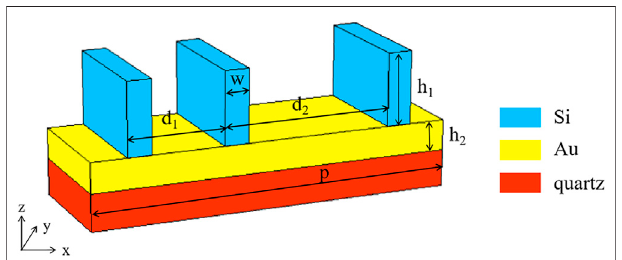
FIGURE 1 | Three-dimensional structure diagram of asymmetric silicon grating.